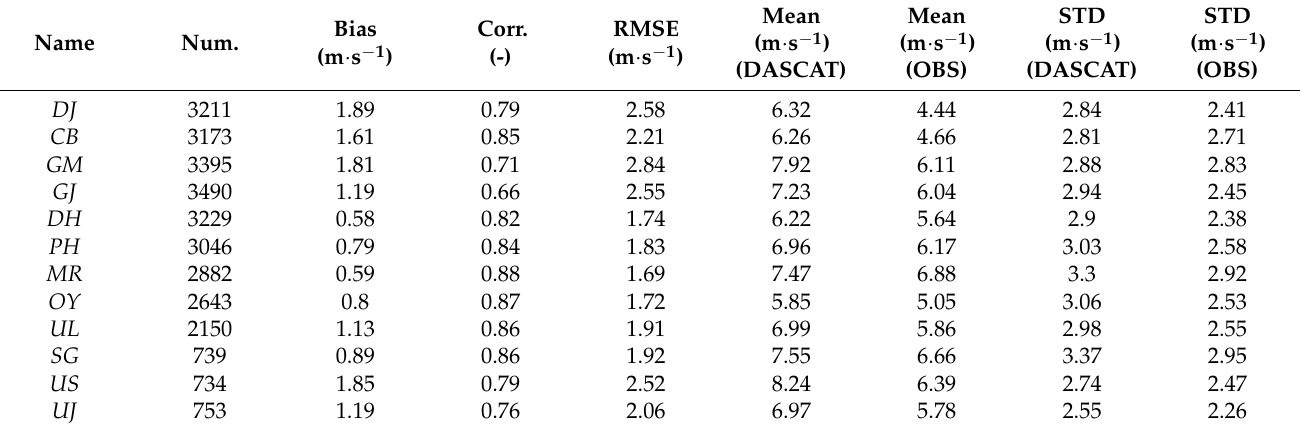
bias at all buoy stations. Since DASCAT was derived from ASCAT level 2b with auxiliary ECMWF analysis data, scatterometer data from some YS and some KS locations are missing. ES buoy locations had a relatively lower bias, RMSE, and higher correlation coefficients than those in the YS and KS. The positive bias of DASCAT estimates increased with buoy wind speeds. These results were similar to those found previously [55], as well as to those from the YS and Bohai Sea [22]. Table 3. Error metrics for the daily wind speeds derived from buoy observation stations (OBS) and DASCAT. Name Num.